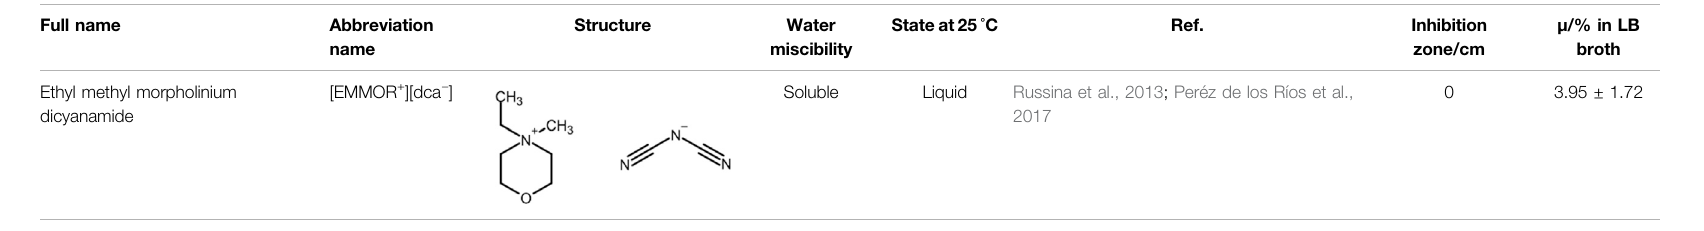
TABLE 5 | Morpholinium-based ionic liquids.